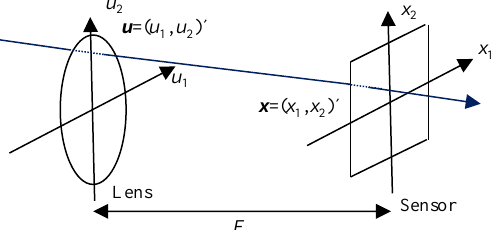
Figure 1. Two plane parameterization of the